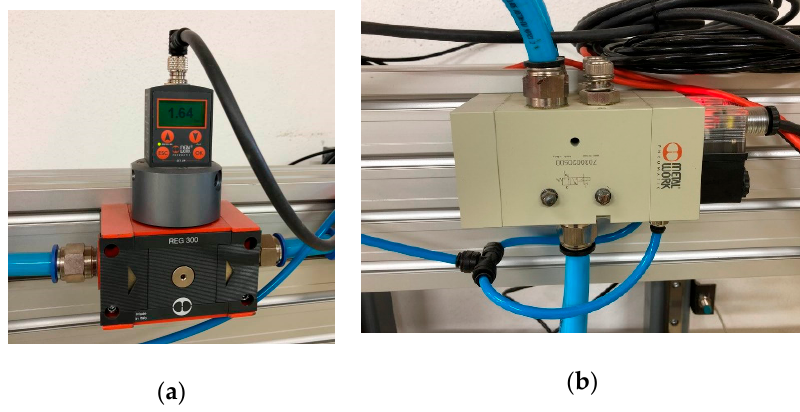
Figure 7. ( a ) Digital pressure regulator; ( b ) two monostable valves.